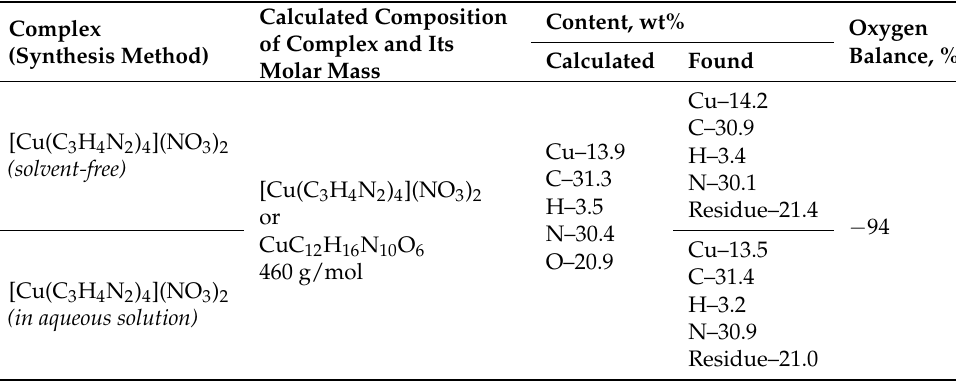
Table 1. Characterization of the synthesized copper